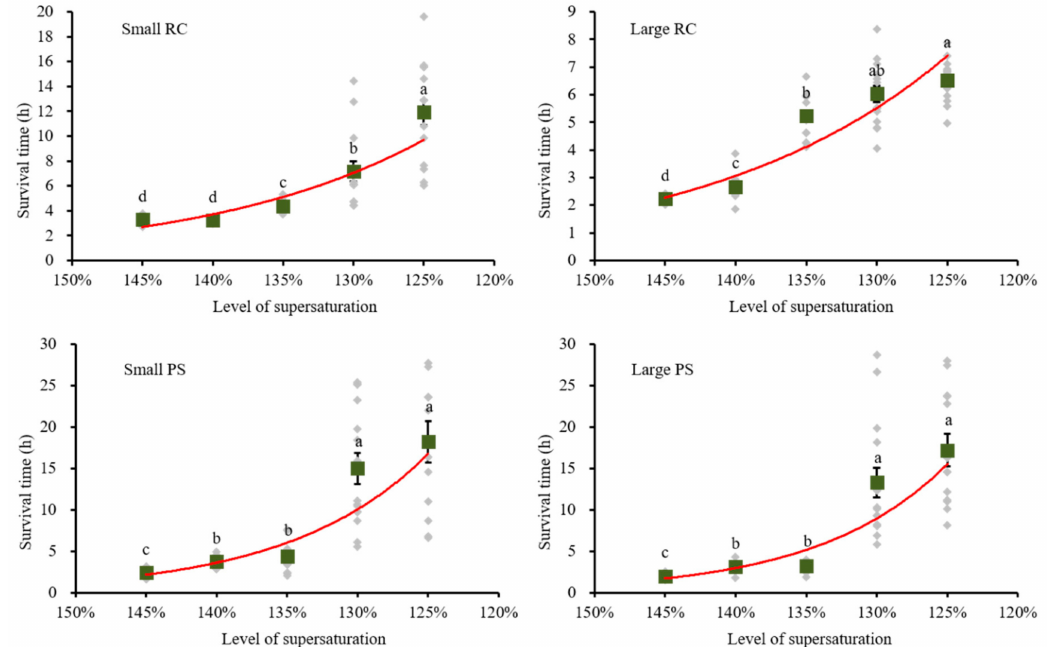
Figure 3. Relationship between survival time and level of supersaturation. Green dots indicate the average survival time. Values are expressed as the mean ± SE, n = 12–15. Gray dots indicate the survival time of the individual. Red lines indicate the best-fit regression models. Letters above the dots indicate the results from a post hoc multiple comparison test between di ff erent supersaturation level. Mean values that do not share a common lowercase letter are significantly di ff erent ( p <